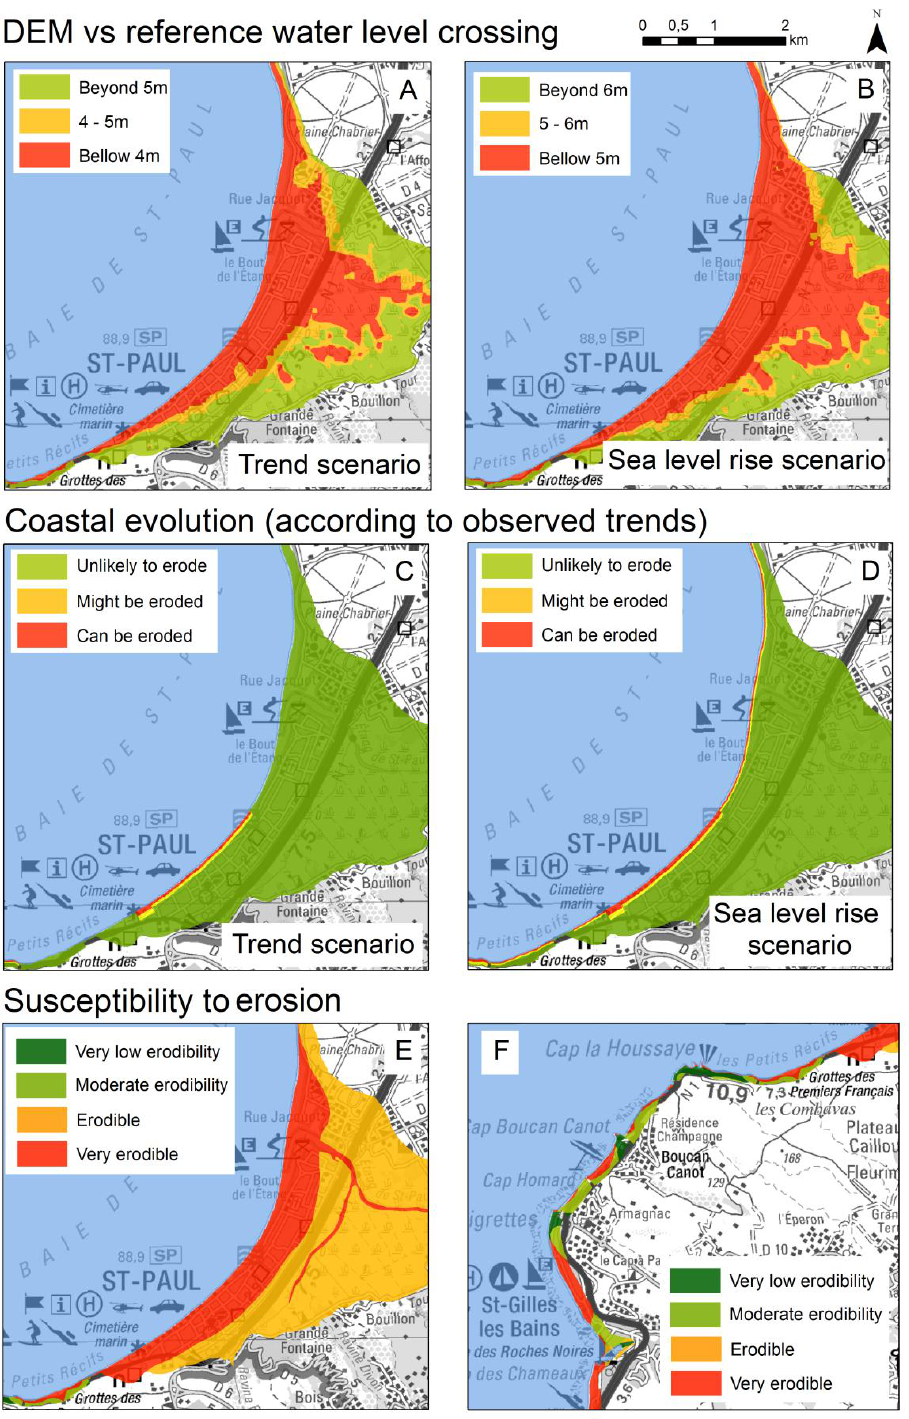
Fig. 4. Baseline geographical data used to estimate state factors: example in La R´eunion near Saint-Paul (north-west). Submersion hazard risk is estimated in two scenarios by crossing reference water levels with a DEM (Maps A and B ). Observed shoreline change is used to estimate how the shoreline may retreat in the future in the trend scenario ( C ) and the sea leve rise scenario ( D ). Erodibility is estimated from geological maps ( E ). Another example of erodibility mapping to the south-west of Saint-Paul is given in map ( F ), showing erodible beaches surrounded by rocky spurs. (Data: BRGM,